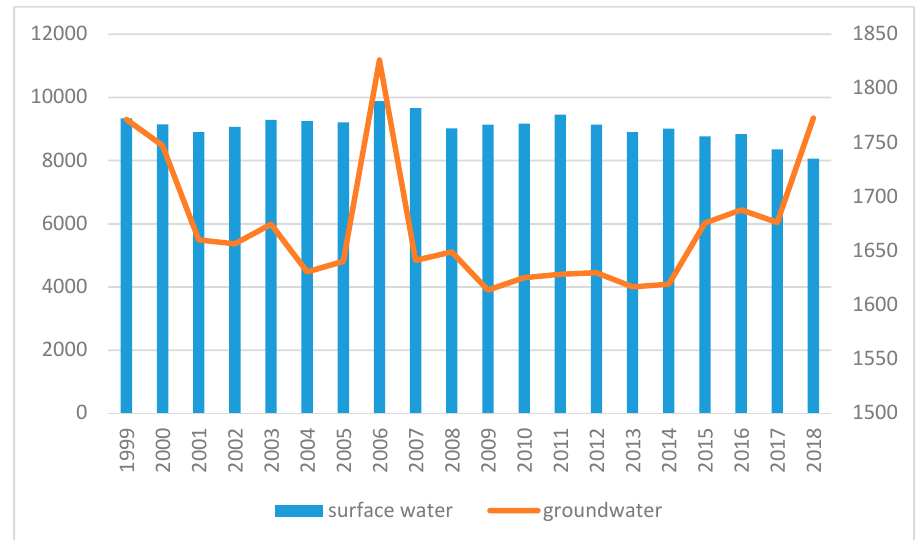
Figure 8. Water consumption (in km 3 ) divided into surface water and groundwater in the period 1999–2018 (based on [26]).